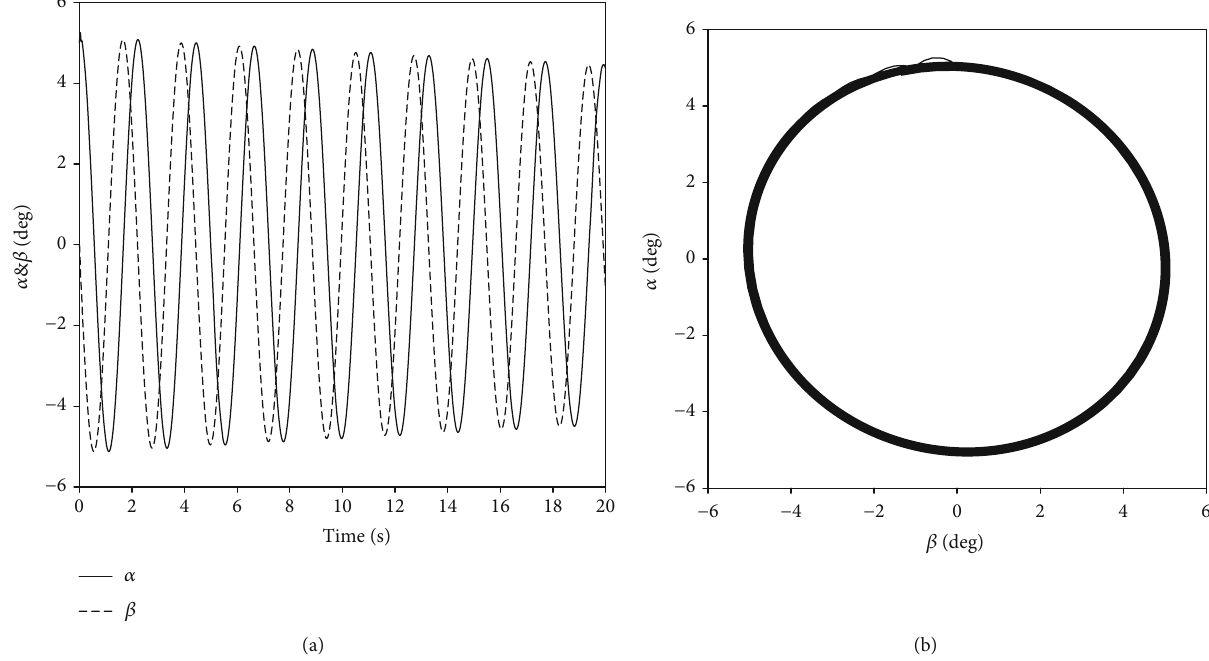
= 0 : 31 . (a) Curves of angle of attack and sideslip. (b) The critical coning Figure 3: Simulation results for k ω